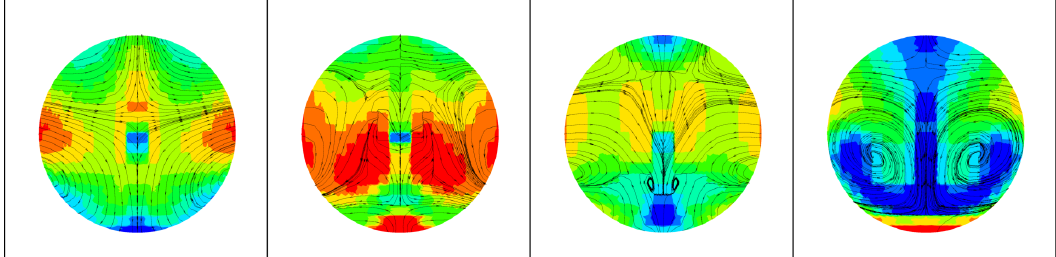
Figure 9. Flow at the propeller disk for four different configurations. From left to right, the original shape, the best shape for the first objective function, the configuration with the best balance between the two objectives and the best configuration for the second objective. Colors are representing the axial velocity of the flow, while the transverse component is indirectly reported by the